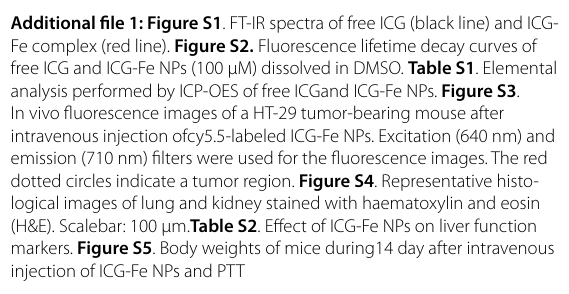
markers. Figure S5 . Body weights of mice during14 day after intravenous injection of ICG‑Fe NPs and PTT Acknowledgements Not